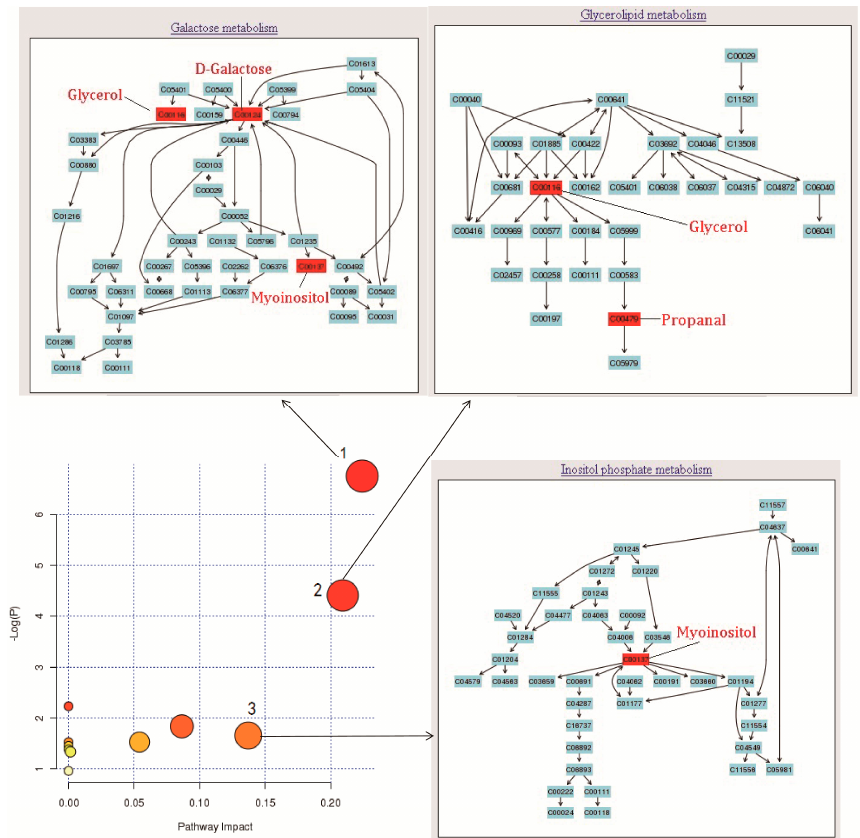
Figure 7. Summary of pathway analysis: (1) galactose metabolism; (2) glycerolipid metabolism; (3) inositol phosphate metabolism.